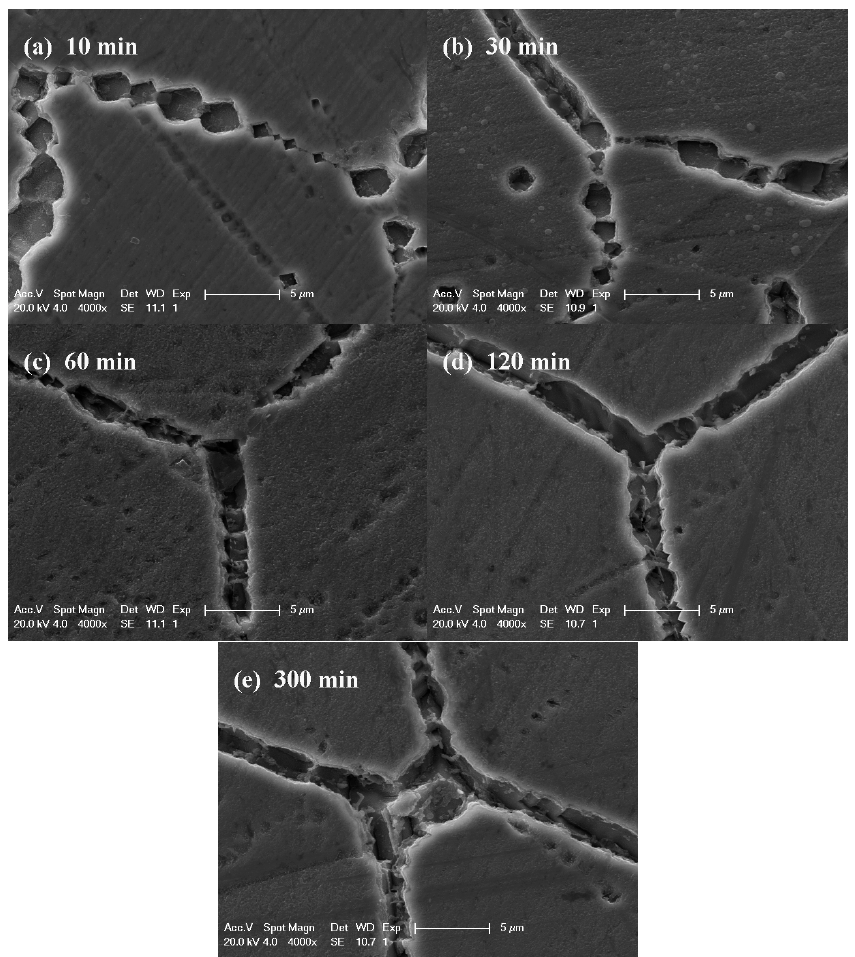
Figure 5. The SEM figures of Cr–Mn–Ni–N–Cu austenitic stainless steel samples treated at 750 °C for different times after the DL-EPR test: ( a ) 10 min; ( b ) 30min; ( c ) 60 min; ( d ) 120 min; ( e ) 300 min.